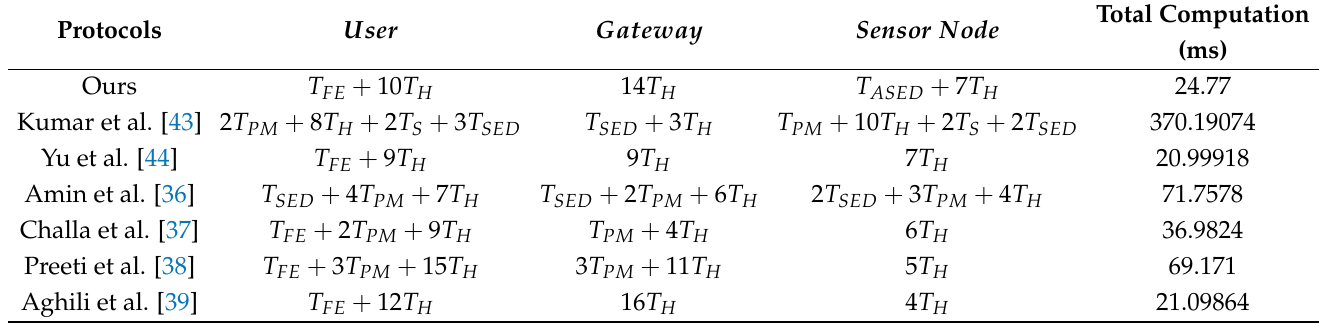
Table 6. Comparison of time.